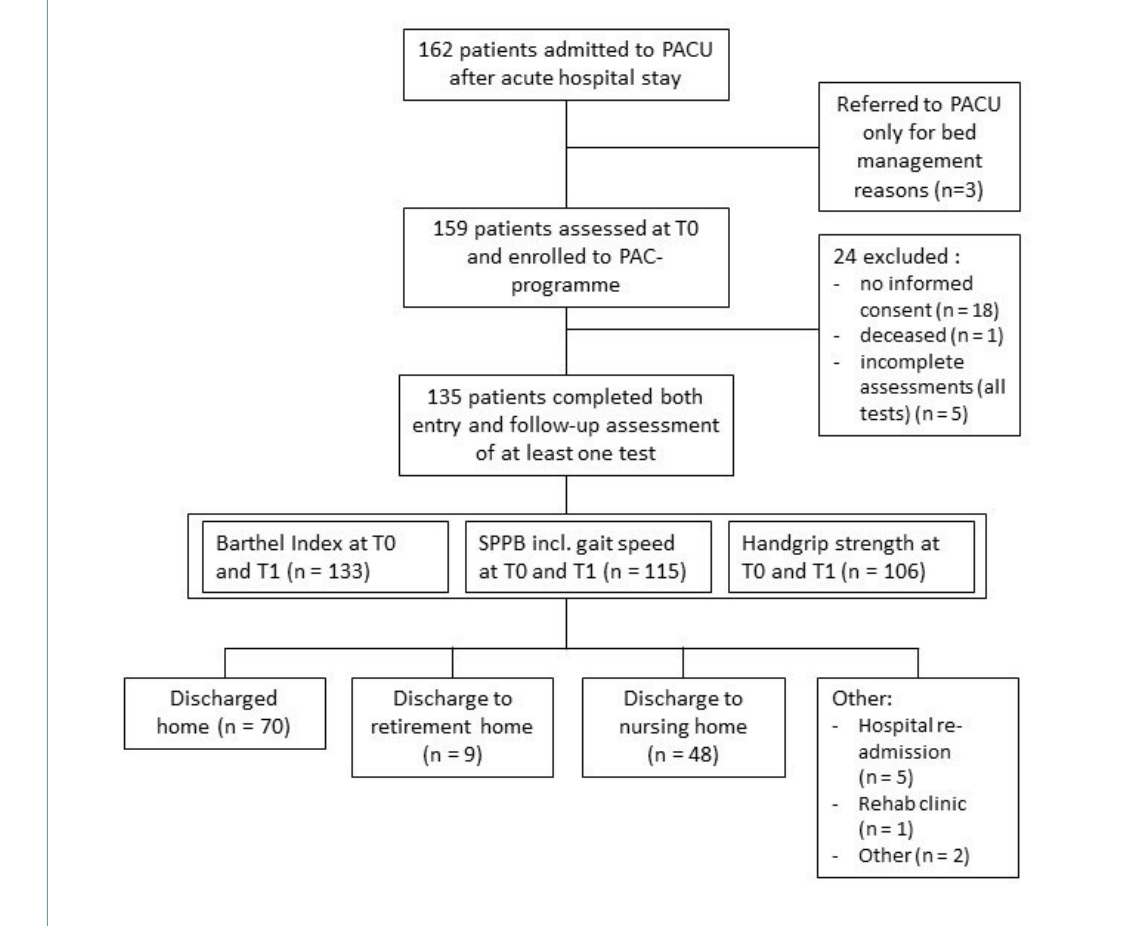
Figure 1: Flow diagram of study participation. PAC = post-acute care; PACU = post-acute care units; SPPB = Short Physical Performance Battery; T0 = time point of assessment at admission; T1 = time point of assessment at